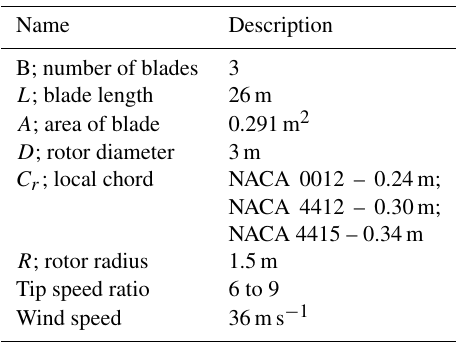
Table 1. HAWT parameter specification.